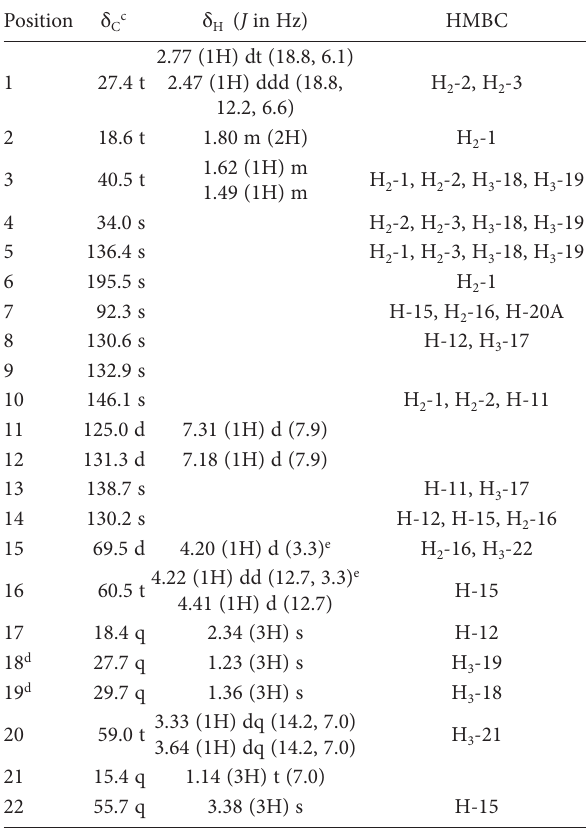
Table 1. 1 H and 13 C NMR and HMBC data for olicleistanone ( 1 ) a,b . Table 2. NOESY data for olicleistanone ( 1 ). Irradiated Observed Irradiated